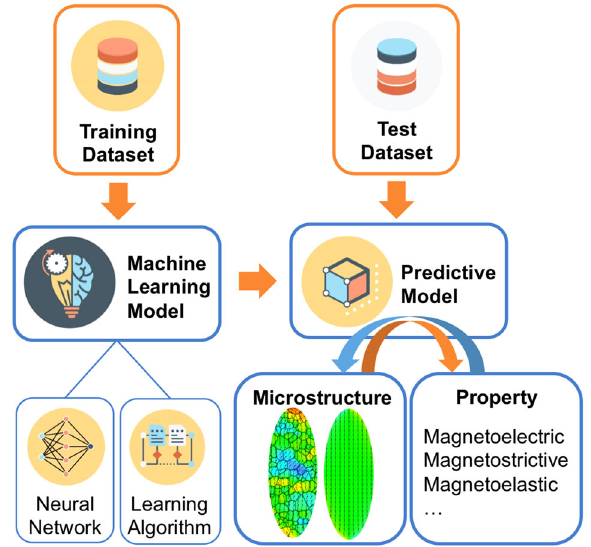
Fig. 11 Envisioned scheme of data-driven computational materials design at the scale of microstructure enabled by supervised machine learning. Training and testing datasets consist of structural and functional imaging data for each spatial location. These data can be obtained through scanning and electron microscopies, where deep-learning imaging recognition can be used to rapidly acquire imaging data and register the structural and functional imaging data. These data can also be obtained through a physical or chemical model. The machine learning model, typically consisting of a neural network and a learning algorithm, aims to discover a statistically correct predictive model from the training datasets. Once passing the test with test dataset, the predictive model can be utilized to predict the materials properties of a newly generated microstructure (see orange arrow ), and inversely, identify a micro- structure that produces optimum properties (see blue arrow ). Phase- fi eld method is one of the best-suited computational tools to generate these microstructures (e.g., the domain and grain structure in an polycrystalline nanomagnet) for all types of